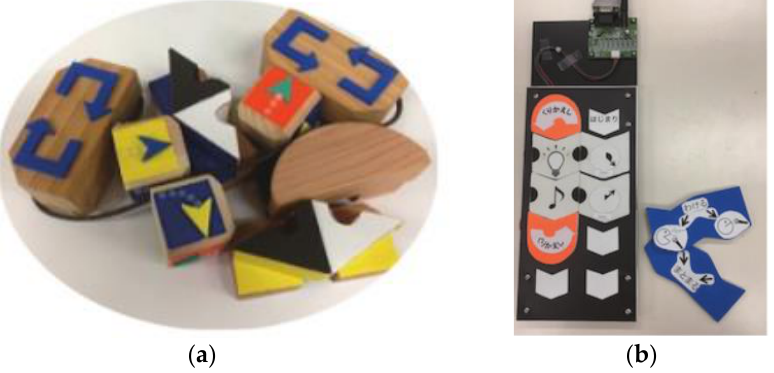
Figure 24. Programming P-CUBEs ( a ), Pro-Tan: programming panel and cards ( b ) [41].